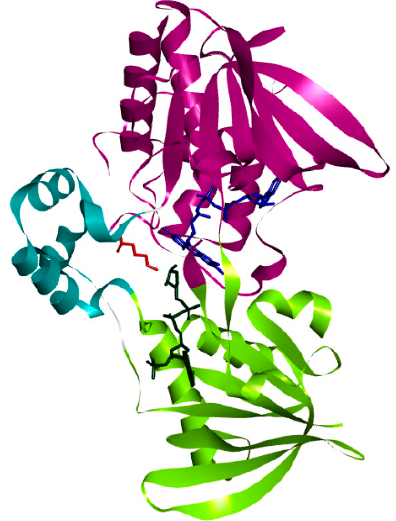
Figure 1. Structure of PvdA: The three domains, namely: the Ornithine-binding domain (cyan), FAD-binding domain (purple), and NADPH-binding domain (green) present in the crystal structure of PvdA are shown.